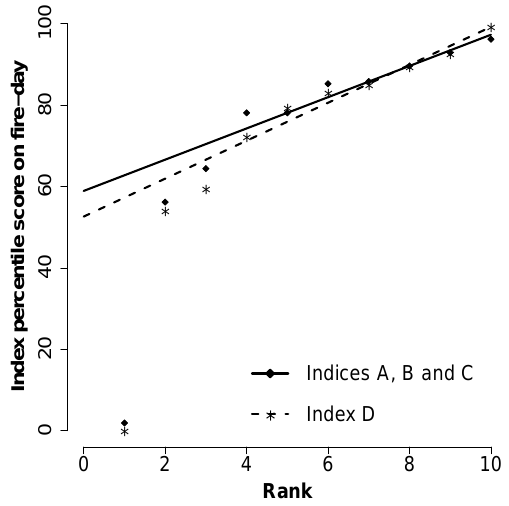
Fig. 4. Characteristics of normalised indices. Top figure shows the percentage of days falling in each index class, while the bottom figure is the percentage of the days in each class that recorded a fire occurrence.